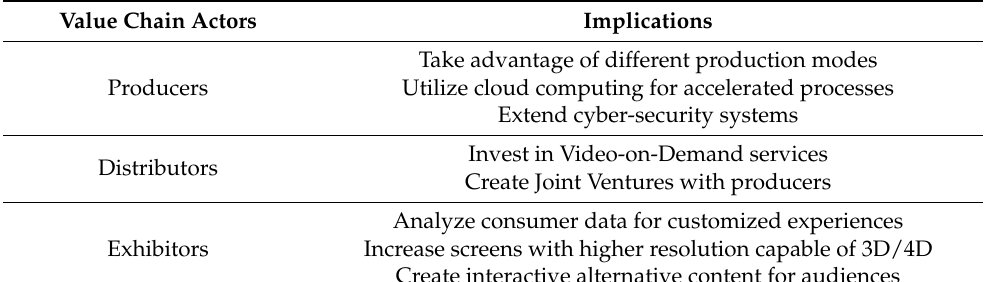
Table 4. Summarized Implications for Value Chain Actors. Source: Own